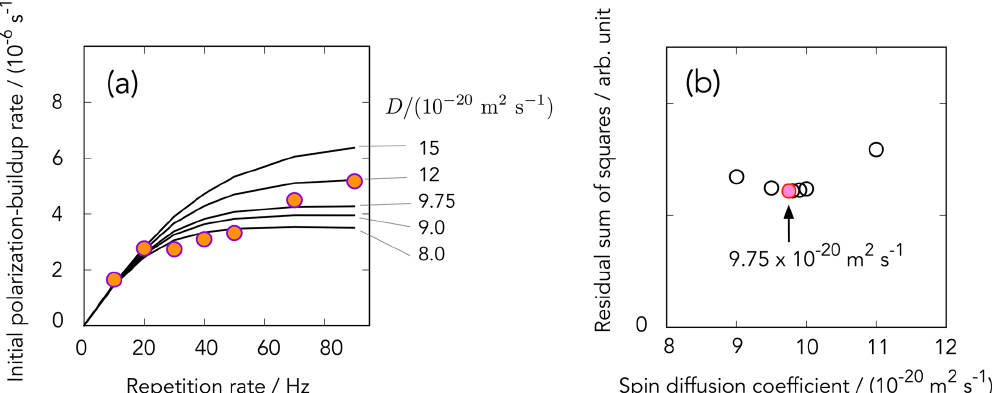
Figure 9. (a) Dependence of the initial buildup rate as a function of the ISE repetition rate R obtained for the PBA sample. The data points indicated by the circles were obtained from the slopes of the buildup curves shown in Fig. 7b at time zero. Solid lines represent the R dependence simulated for various spin-diffusion coefficients D according to the model described in the text. (b) A plot of the residual sum of squares calculated for various spin-diffusion coefficients, which gave the minimum for D = 9 . 75 × 10 − 20 m 2 s − 1